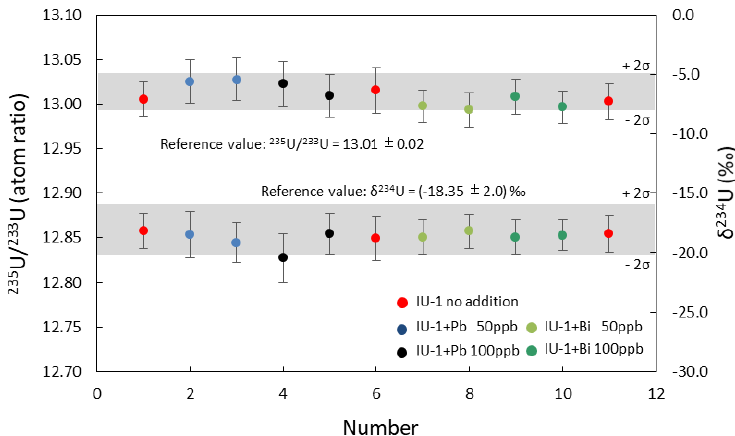
Figure 2. Relative recovery (measured vs. loaded) and elution fractions for the standard SS-1.